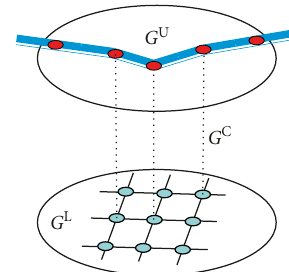
Figure 2: The multilayer network representation method.